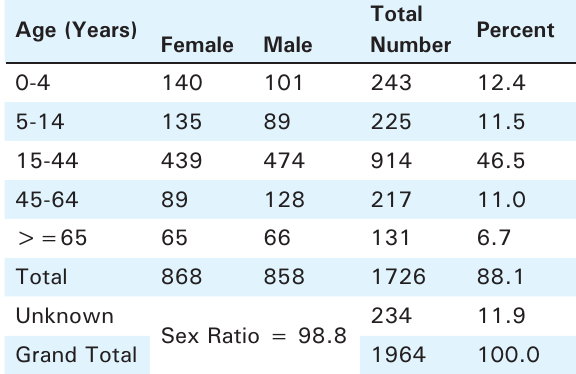
Table 1. PH ED patients by age groups and gender